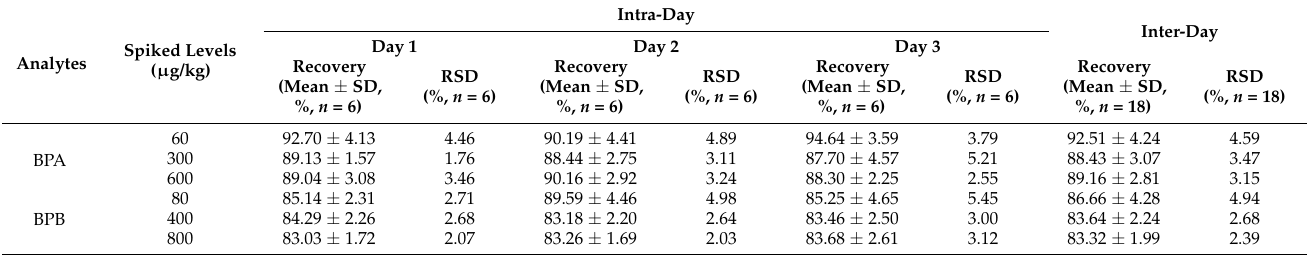
Table 1. Accuracy and precision of the proposed method at three spiked